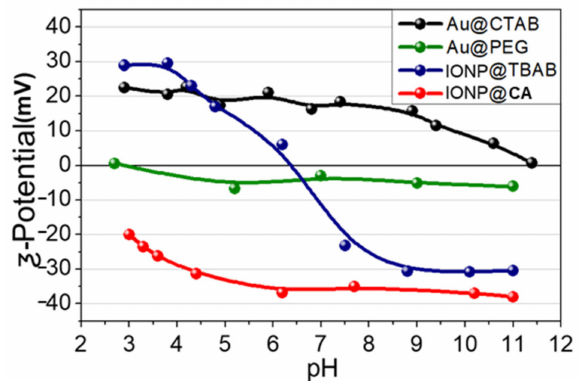
Figure 3. B -potential dependence with pH of: Au@CTAB (black), Au@CTAB (green), IONP@TBAB (blue), and Au@CA (red).